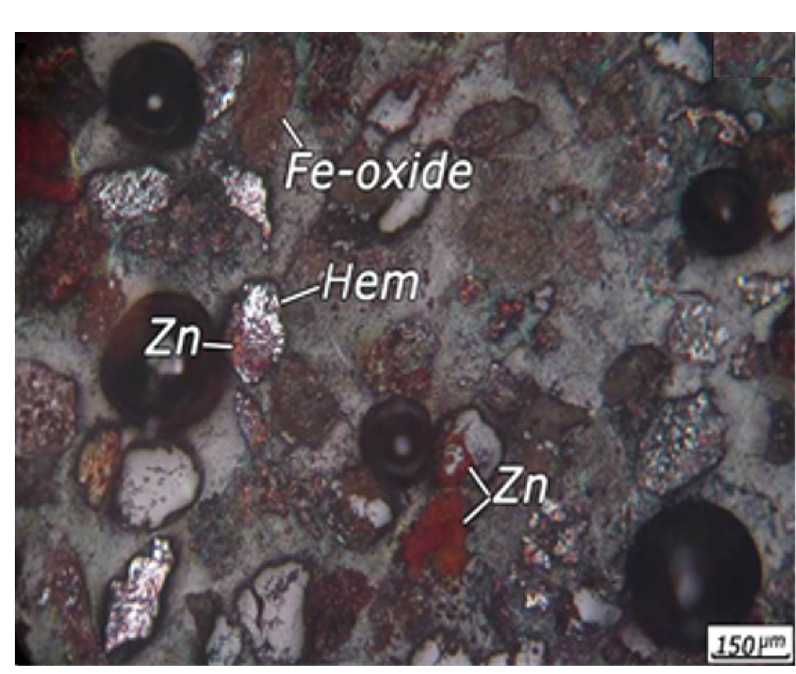
Figure 1. An optical microscopic image from + 90 µm size fraction showing the presence of Hem = Hematite, Zn = Zn oxide minerals, Fe-oxide = Fe oxide minerals in the